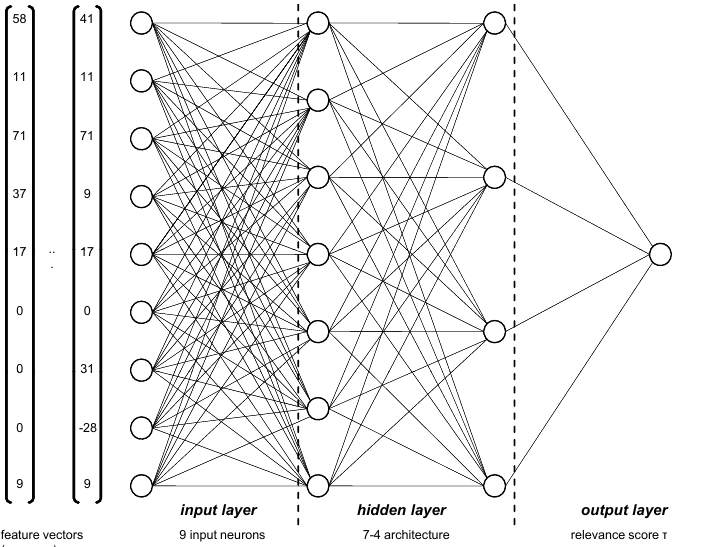
Figure 2: neural network for relevance ranking – the used neural network predict for a vector ~ω of 9 feature values the relevance of the database